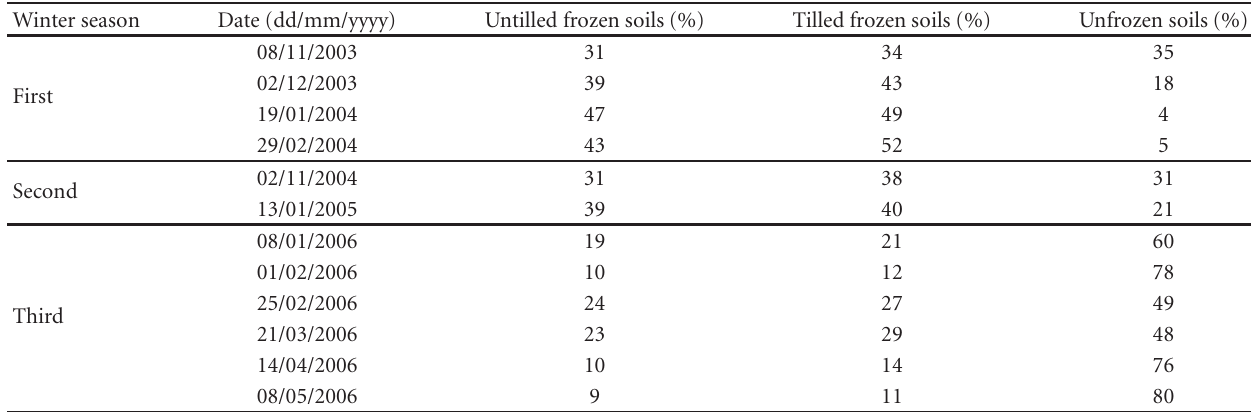
Table 8: Distribution of frozen/unfrozen soils for the12 radar images acquired during the three winter seasons (2003-2004 to 2005-2006) over the Bras d’Henri watershed, by land